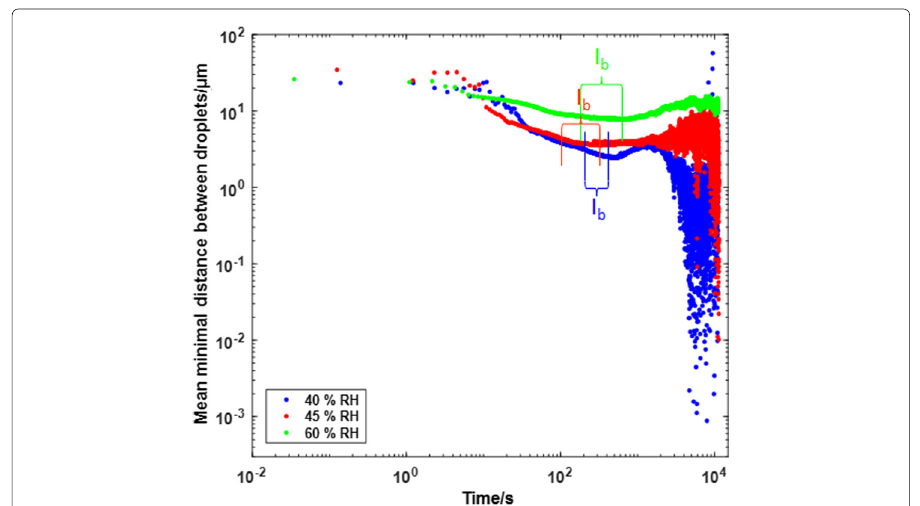
Fig. 7 Mean spacing between each droplet and its closest neighbor < d b > as a function of time. The measured distances are edge to edge. I b describe phase I